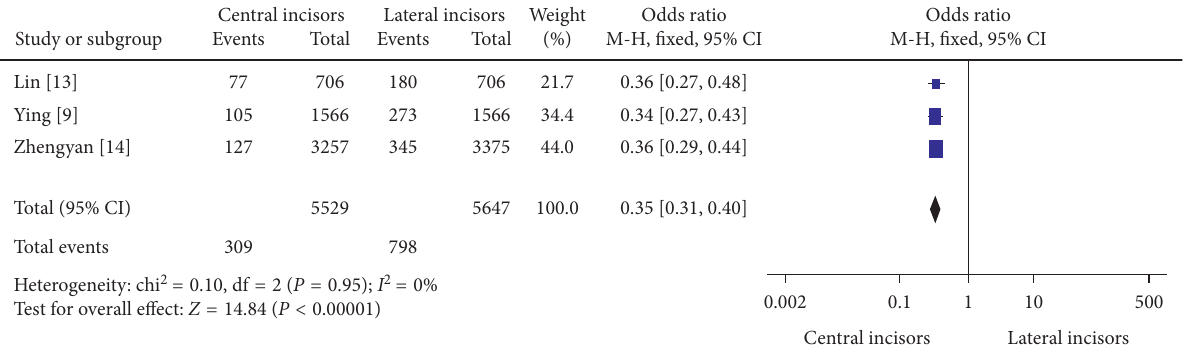
Figure 1: The evidence of second canal between permanent mandibular central and lateral incisors in China.